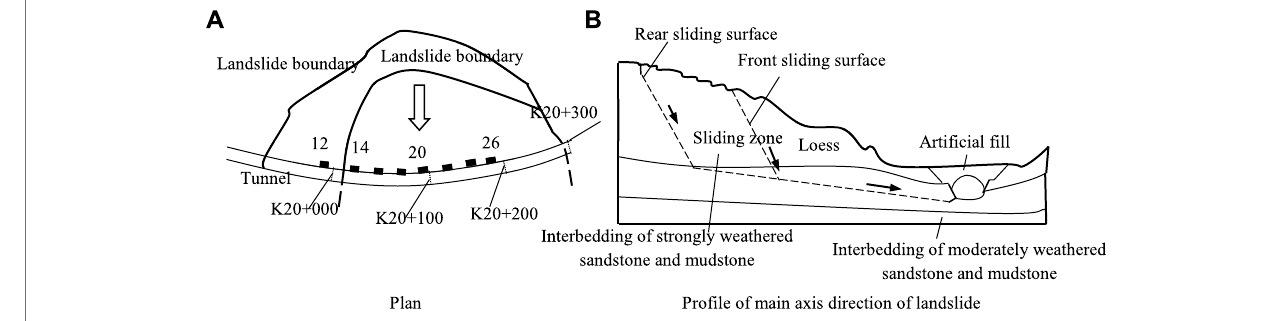
FIGURE 5 | Location relationship between the Nanping tunnel and landslide.